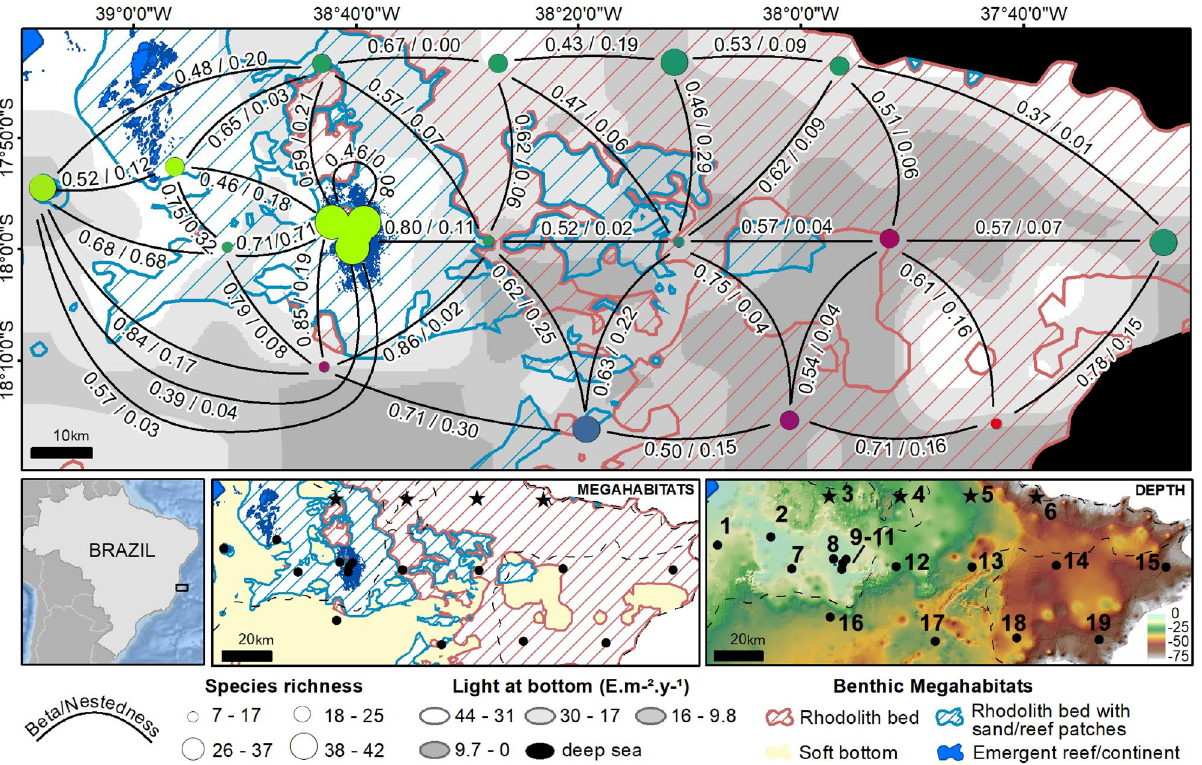
Figure 1. Beta diversity in reef fish assemblages, Abrolhos Shelf. In the larger map (above), color similarity among sites (circles) indicates similar assemblages as measured by their beta diversity distances in a two- dimensional ordination space (see “Methods”) and color circle size corresponds to fish richness; light at bottom and megahabitats were the most important variables in the GDM and are represented as shades of gray scale and stripped patterns, respectively. The arcs connecting sites represent the pairwise total beta/Nestedness components. The lower row shows the localization of the study region, megahabitat distribution and depth (color scale in meters). Sites marked with stars are those depicted in Fig. 5. The number of BRUV deployments at each numbered site (lower right) was: 1 = 16; 2 = 9; 3 = 12; 4 = 7; 5 = 7; 6 = 7; 7 = 4; 8 = 12; 9 = 5; 10 = 9; 11 = 9; 12 = 8; 13 = 7; 14 = 4; 15 = 8; 16- 6; 17 = 6; 18 = 6; 19 = 4 (total = 137 deployments, 1 h each). Map produced with ArcGIS 10.6 (www.esri.com) by J. T. Gonçalves, L. A. Carlos Jr and R. L.